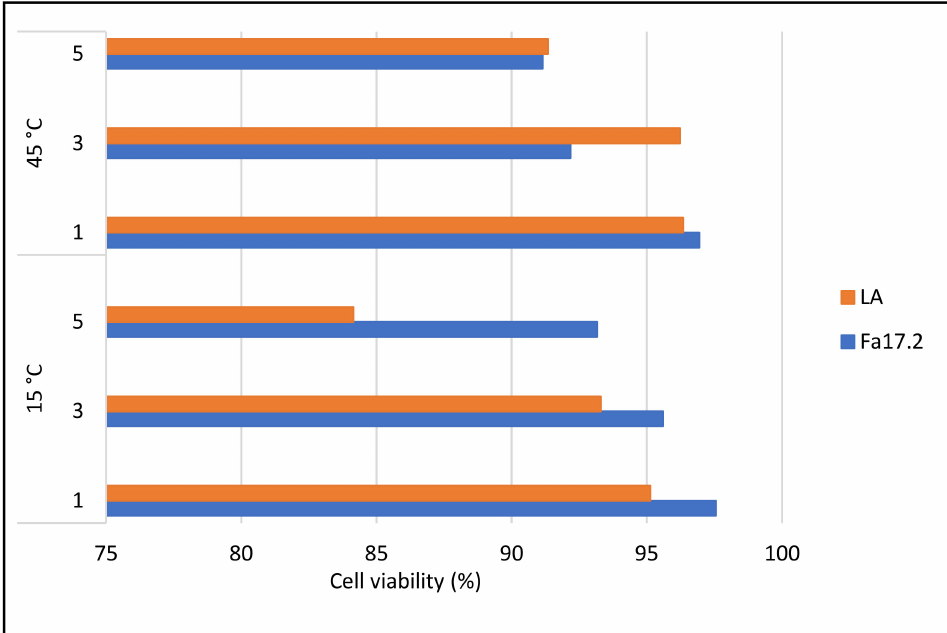
Figure 3. Cell viability (%) in different concentrations of NaCl upon 24 h of incubation at 15 ◦ C and 45 ◦ C. Legend: Fa17.2: B. subtilis Fa17.2; LA: L. acidophilus